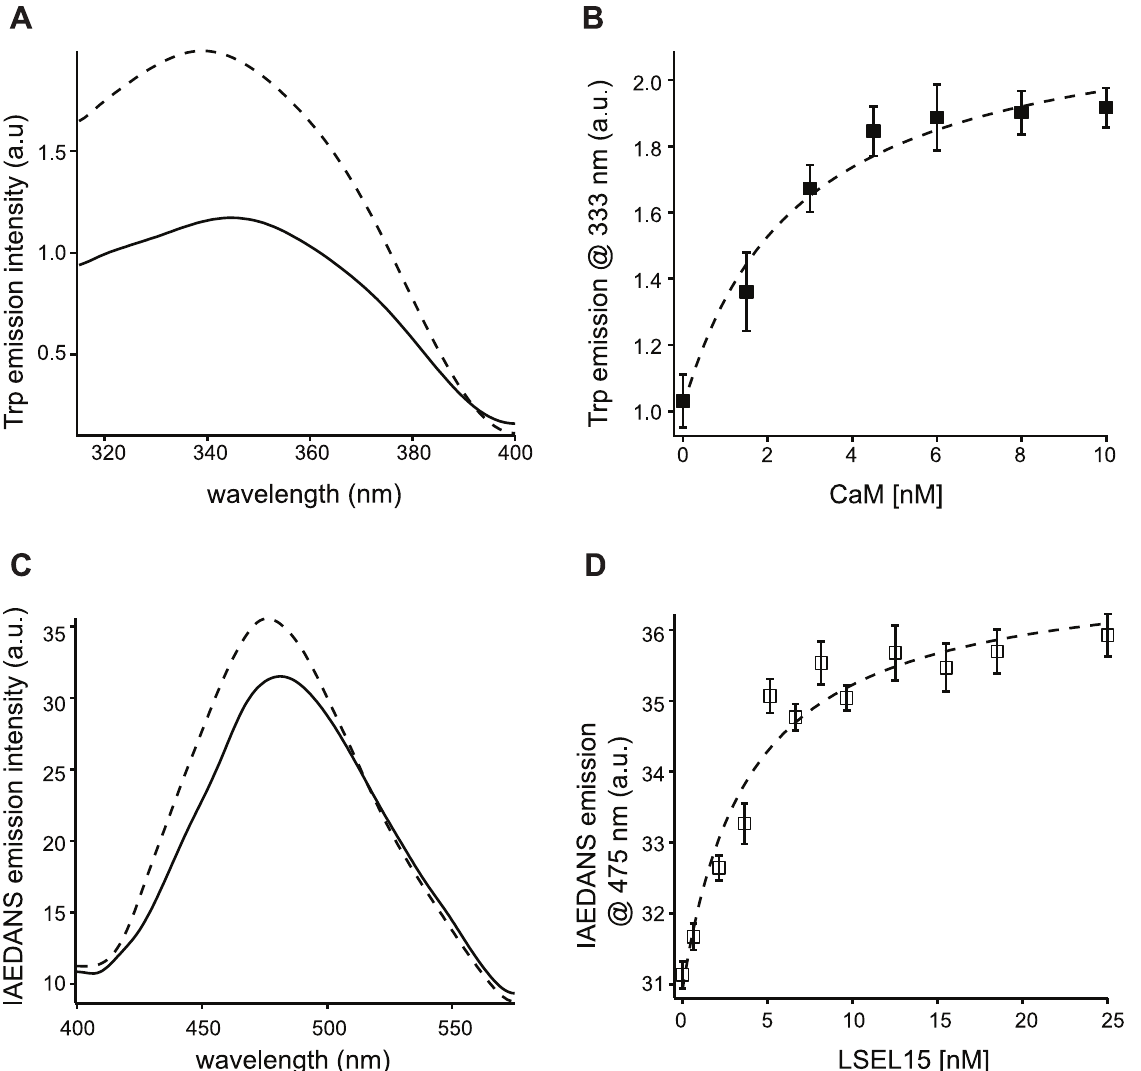
Figure 2. The association of I-CaM with LSEL15 in aqueous solution. A, Trp fluorescence emission spectra of 1 nM LSEL15 in the absence (solid line) and presence (dash line) of 10 nM Ca 2 + -loaded CaM. LSEL15 and CaM were dissolved in 2 ml of 10 mM MOPS, 0.3 mM CaCl 2 , 100 mM NaCl, 0.1 mg/ml BSA, pH 7.4. The emission spectra were obtained with the excitation wavelength at 295 nm and each was the average of 3 scans. Both spectra were corrected for background fluorescence from the buffer. B, the titration plot of LSEL15 by Ca 2 + -CaM. CaM was titrated to the LSEL15 solution at indicated concentrations, and the Trp emission at 333 nm was measured. Dashed line indicates the fitted binding curve. C, IAEDANS fluorescence emission spectra of 1 nM Ca 2 + -I-CaM in the absence (solid line) and presence (dash line) of 25 nM LSEL15. I-CaM and LSEL15 were dissolved in 2 ml of the same buffer as in (A). The emission spectra were obtained with the excitation wavelength at 340 nm and each was the average of 3 scans. Both spectra were corrected for background fluorescence from the buffer. D, the titration plot of Ca 2 + loaded I-CaM by LSEL15. LSEL15 was titrated to the I-CaM solution at indicated concentration, and the IAEDANS emission at 475 nm was measured. Dashed line indicates the fitted binding